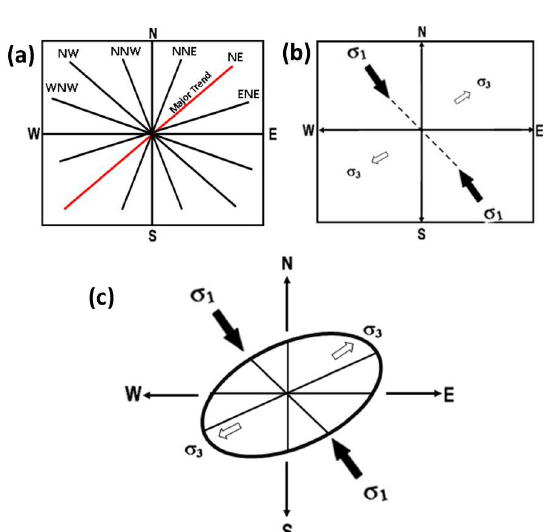
Figure 12: Kinematics of Strain and associated stress patterns with respect to the tectonic structure of the study area with emphasis on the two phases of deformational ellipsoid (a) Different orientations, with the NE–SW fractures as the major trend, (b) the trends of the main stress axes σ 1 – σ 3 (c) integrated kinematic strain analyses indicating deformational ellipsoidal trend Modified from (Solomon and Ghebreab